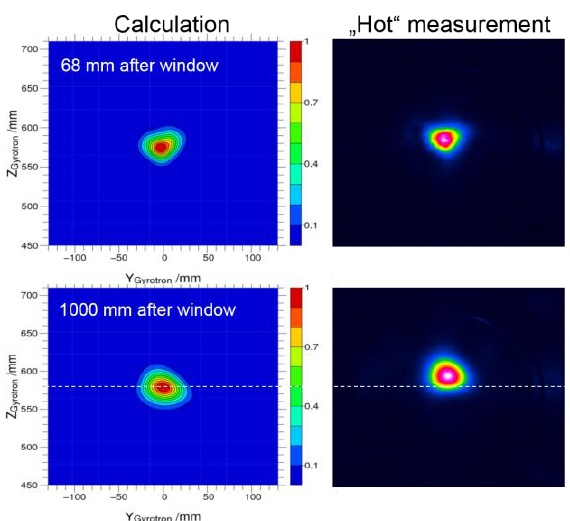
Fig. 3. Intensity distribution of the calculated and measured (IR-image) gyrotron RF output beam in 68 mm and 1000 mm distance from the window [21] (qualitative